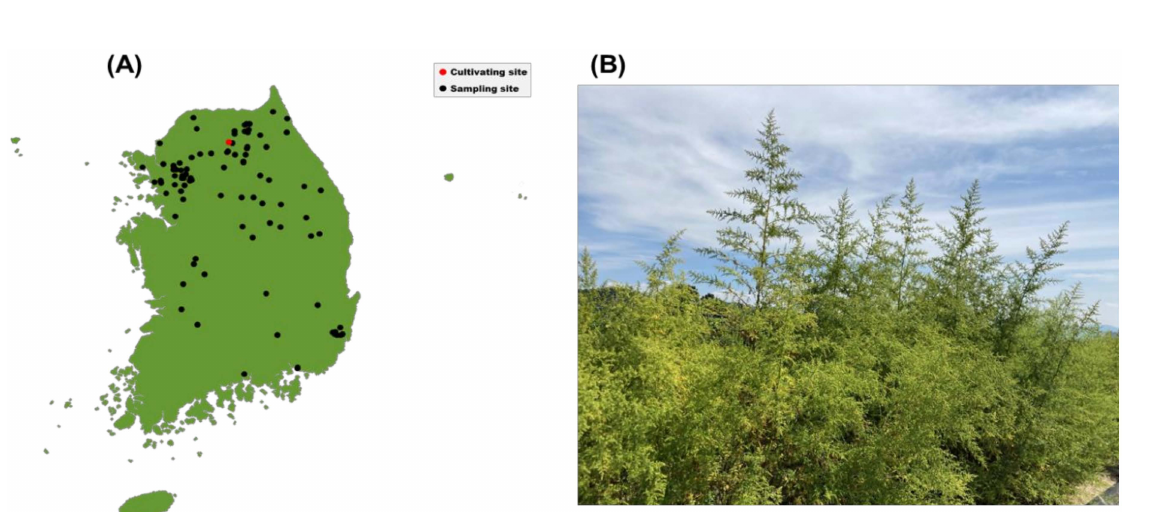
Figure 6. ( A ) Sampling sites of A. annua seeds marked as black dots and their cultivation site also marked as a red dot in Korea; ( B ) View of cultivation fields for A. annua